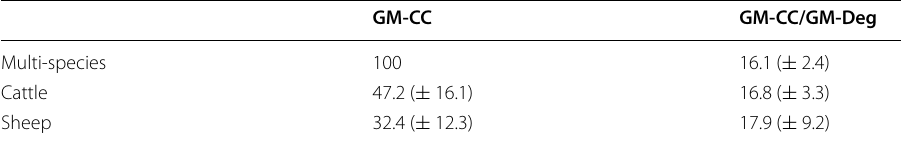
Table 5 Table showing average results in dynamic network analysis and comparing with static network analysis results